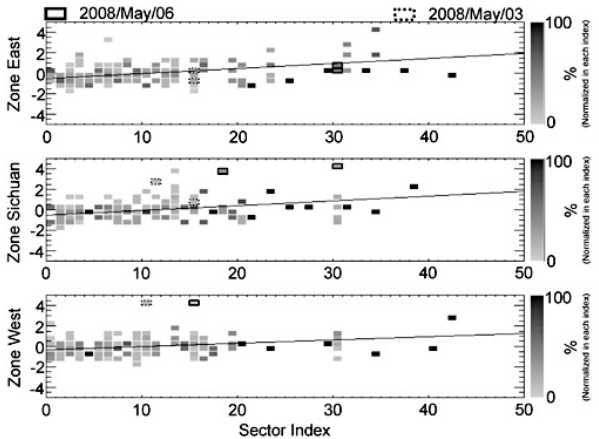
Fig. 6. Statistical distribution of the power index of electrostatic turbulence as a function of local magnetic activity derived from the αλ magnetic indices. Data corresponding to the large deviations prior to the earthquake are marked by solid and dotted rectangles. Linear fits of data are